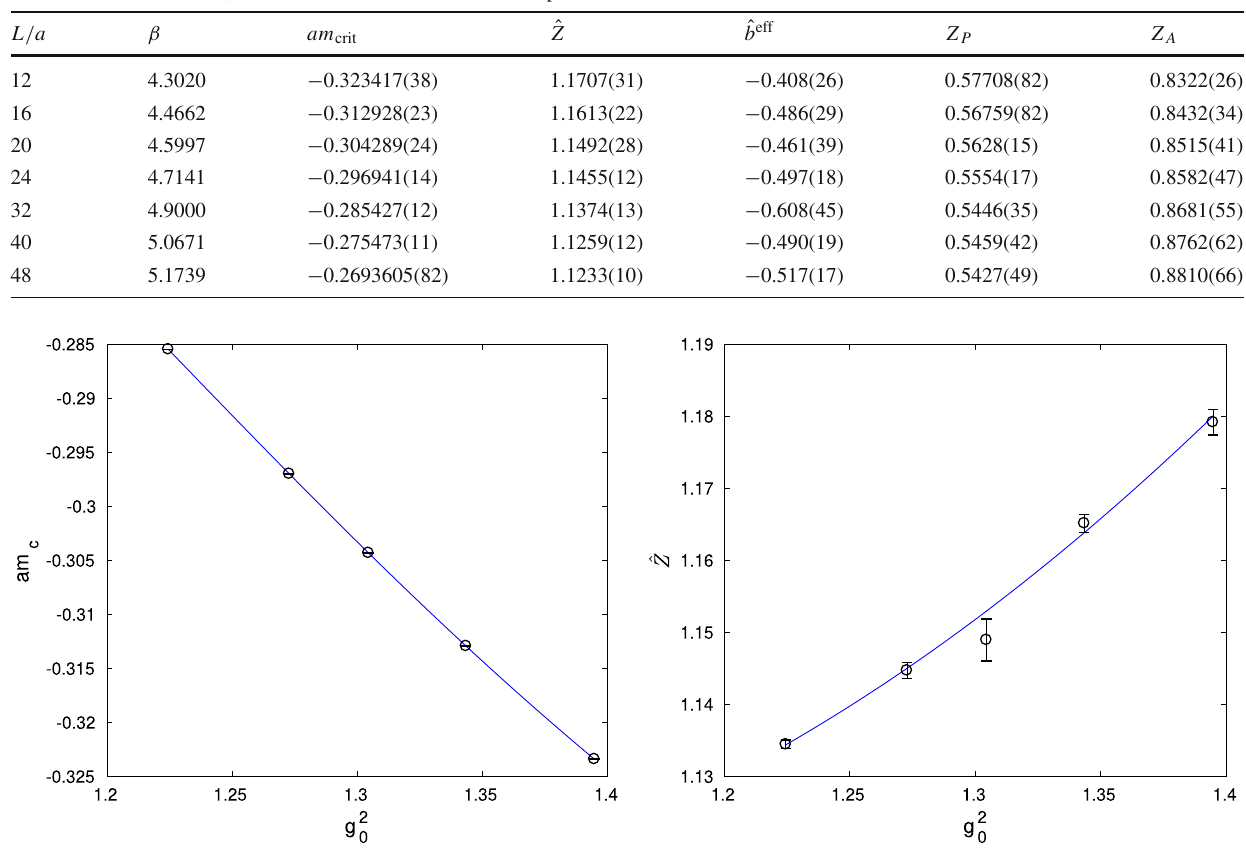
Table 13 Results for am crit , ˆ Z , ˆ b eff and Z P from fits and extrapolations of Z A